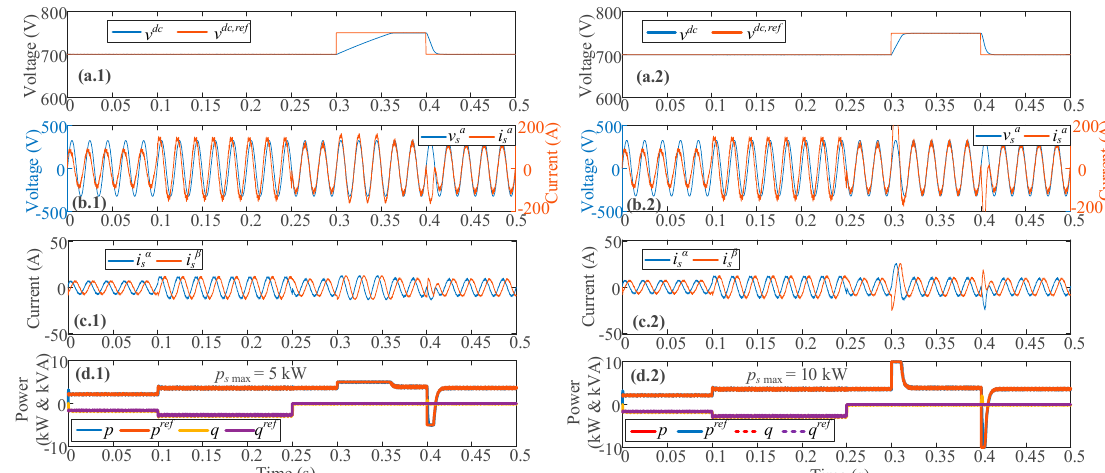
Figure 3. Simulated Results, ( a ) dc voltage and reference, ( b ) v s α voltage and i s α current, ( c ) i s αβ currents, ( d ) active p s and reactive q s power; ( 1 ) p s max = 5 kW, ( 2 ) p s max = 10 kW.